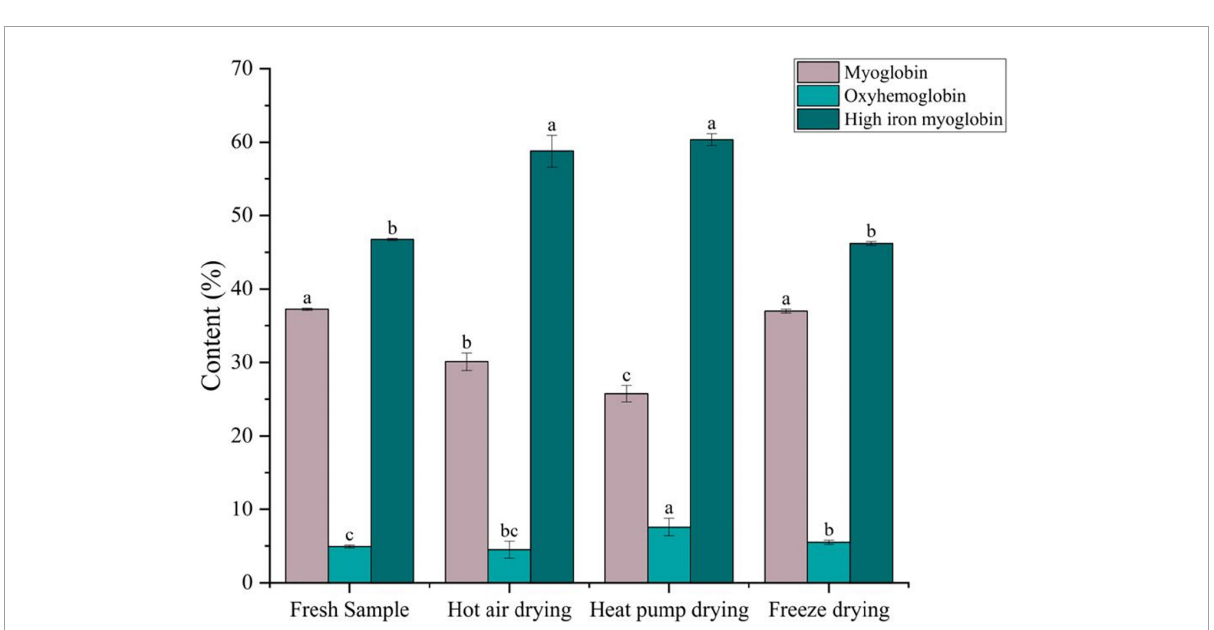
FIGURE6 Effects of different drying methods on the content of different forms of myoglobin. Different colored bars represent different forms of myoglobin. Lower case letters indicate significance at p <